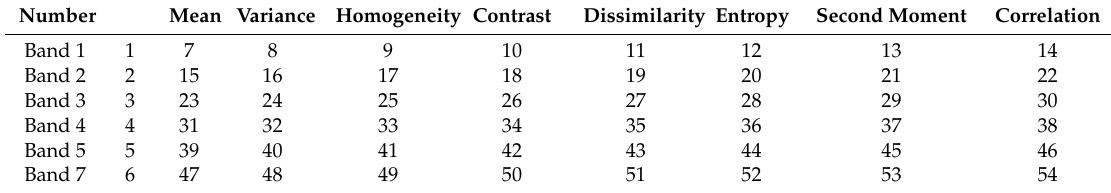
Table 3. Sequence number table of spectral and textural features.